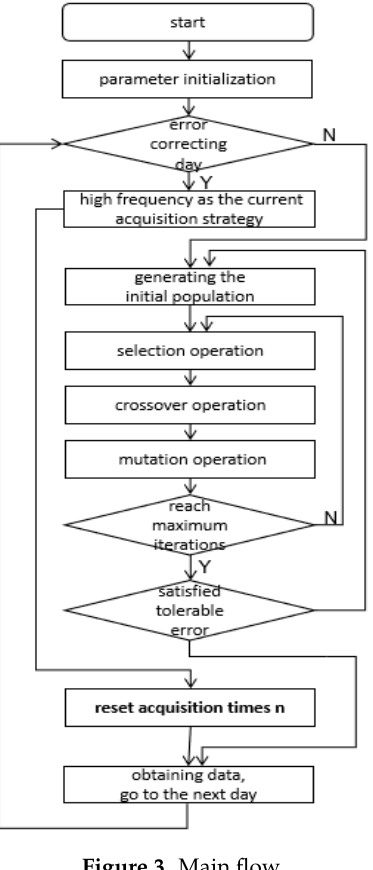
Figure 3. Main Figure 3. Main flow.